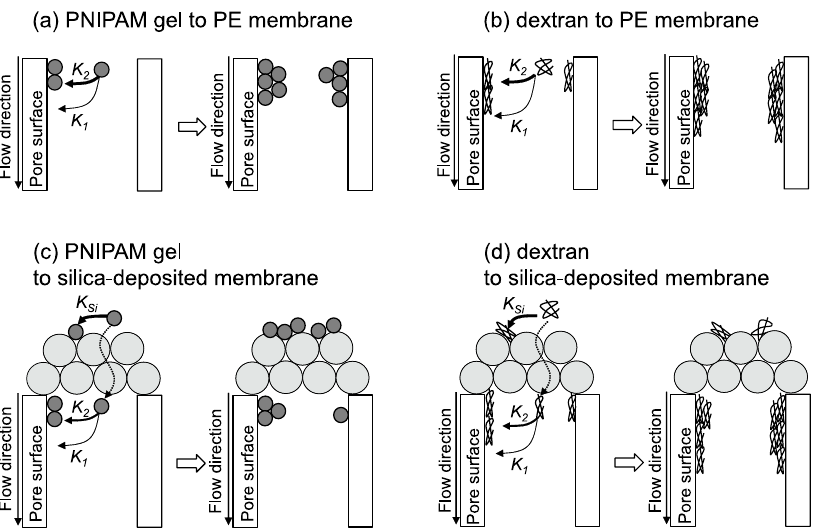
Figure 6. Schematics of PNIPAM gel and dextran filtration by PE and silica-deposited membranes. ( a ) permeation of PNIPAM gel solution to PE membrane, ( b ) permeation of dextran solution to PE membrane, ( c ) permeation of PNIPAM gel solution to silica-deposited membrane, and ( d ) permeation of dextran solution to silica-deposited membrane.